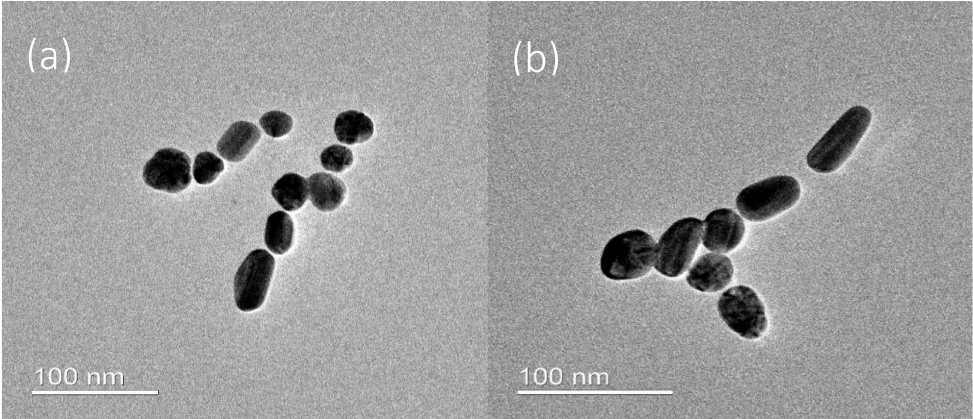
Figure 2. Transmission electron microscopy (TEM) micrographs of ( a ) Ag nanoparticles (NPs), and ( b )